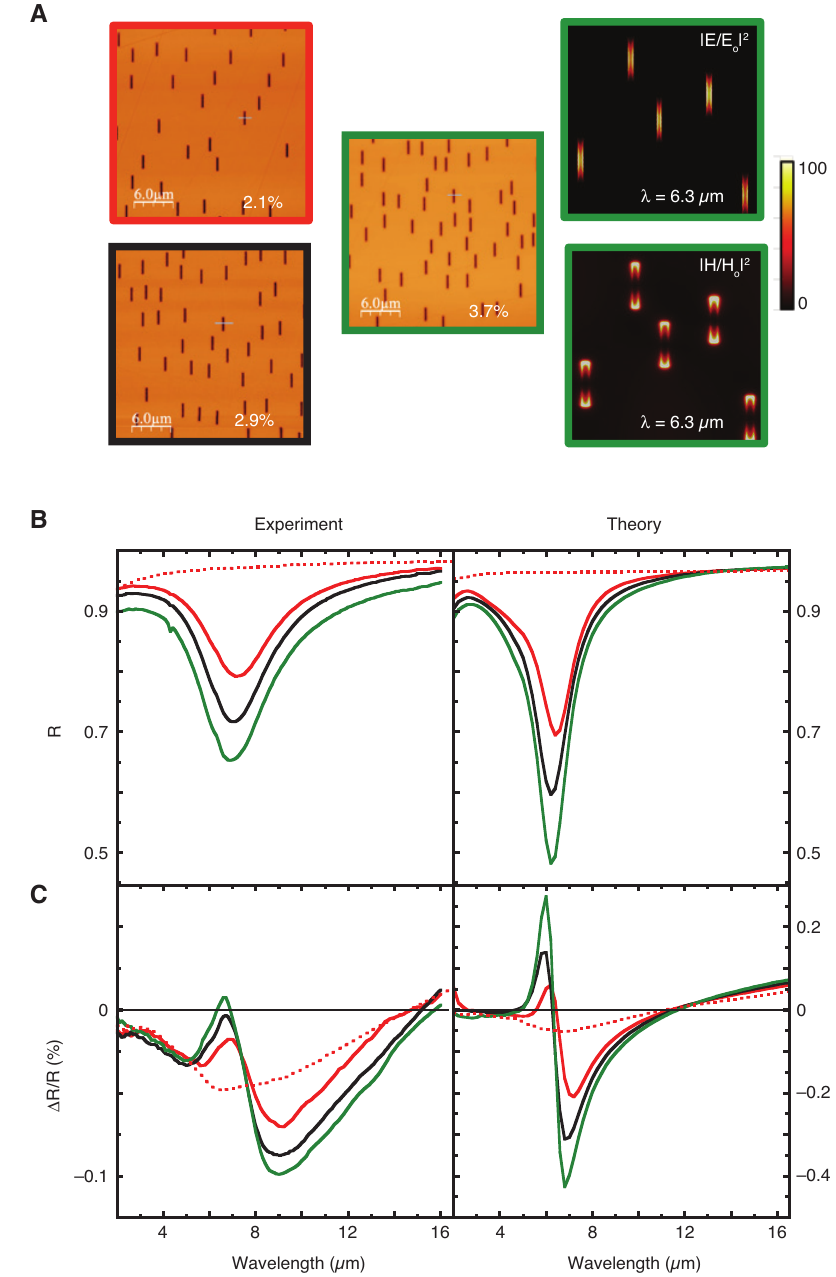
Figure 2: Dependence of the reflectivity and its magnetic field modulation on the concentration of slits. (A) Atomic force microscopy images of the fabricated arrays for three different slits concentrations: 2.1% (red line), 2.9% (black line), and 3.7% (green line). The length of the slits is 2 microns. The electromagnetic field maps calculated for the sample of 3.7% slit concentration are shown on the right side. (B) Experimental (left) and theoretical (right) reflectivity (R) for the three slits arrays, for light polarized perpendicular (full lines) and parallel to the slit long axis (dotted line), respectively. (C) Magnetic modulation of the reflectivity ( Δ R/R) for the three slits arrays of different concentrations, for perpendicularly polarized light (full lines) and parallelly polarized (dotted line),